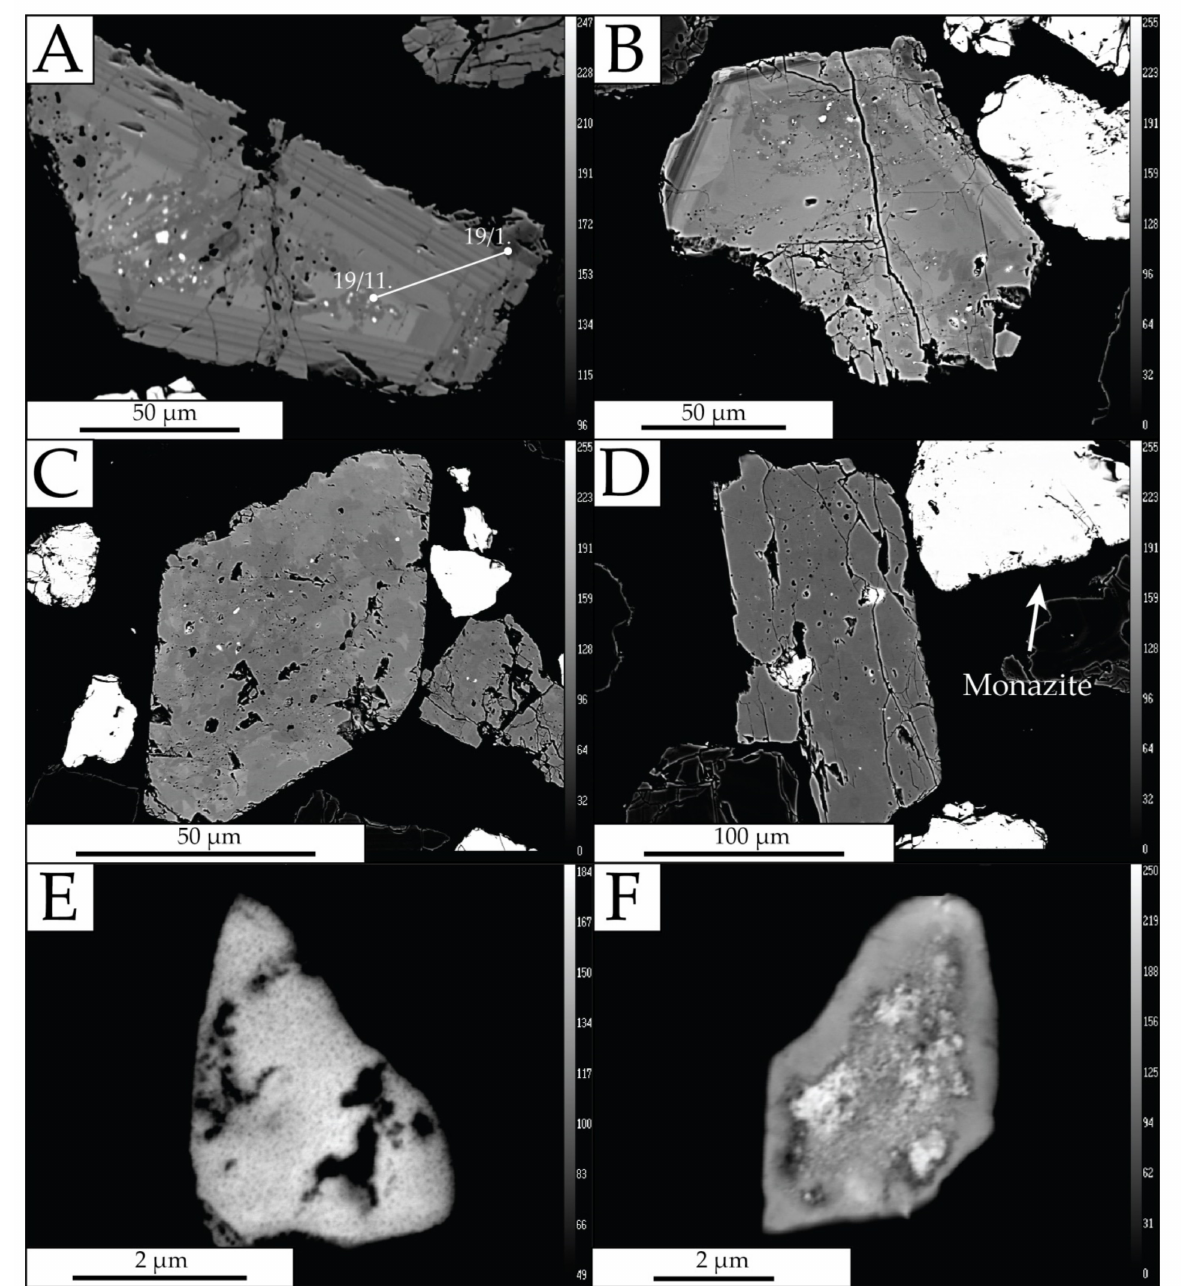
Figure 8. Backscattered electron images of xenotime and thorite-uranothorite grains. ( A ) xenotime with oscillatory zoning boundary with a thorite inclusion in the center. The core has an irregular composition; ( B ) xenotime with a zoning rim; ( C ) euhedral xenotime with a thorite inclusion. The high porosity of the grain; ( D ) subhedral xenotime with a large inclusion of thorite-uranothorite; ( E ) inclusion of a thorite grain with high porosity; ( F ) irregular composition of a thorite